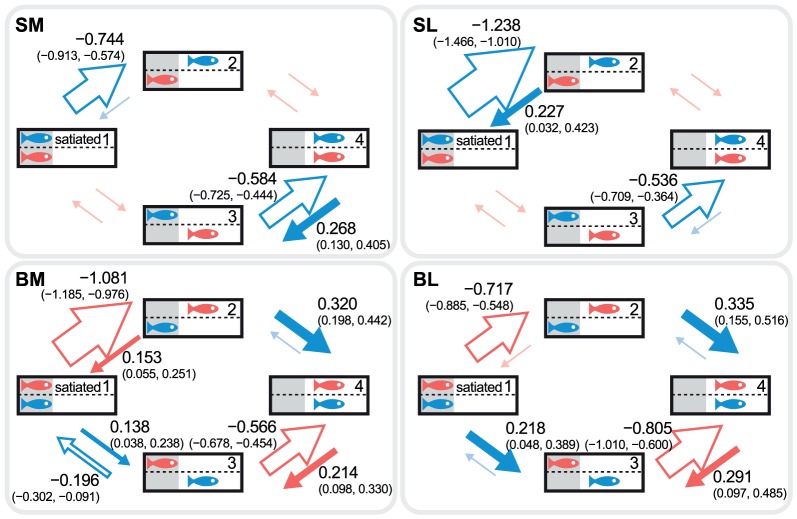
Log-linear effects of satiation from the Markov chain model.Log-linear effects of satiating focal fish estimated from the Markov chain models (best estimates and 95% CI). SM: focal fish are moderately shyer than their partner before satiation, SL: focal fish greatly shyer than their partner, BM: focal fish moderately bolder than their partner, BL: focal fish greatly bolder than their partner. Filled arrows and open arrows in (B) indicate positive and negative effects, respectively.